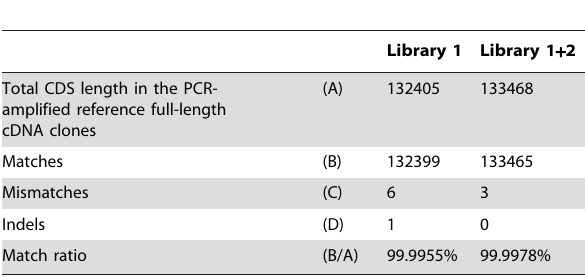
Table 4. Base accuracy of consistent coding